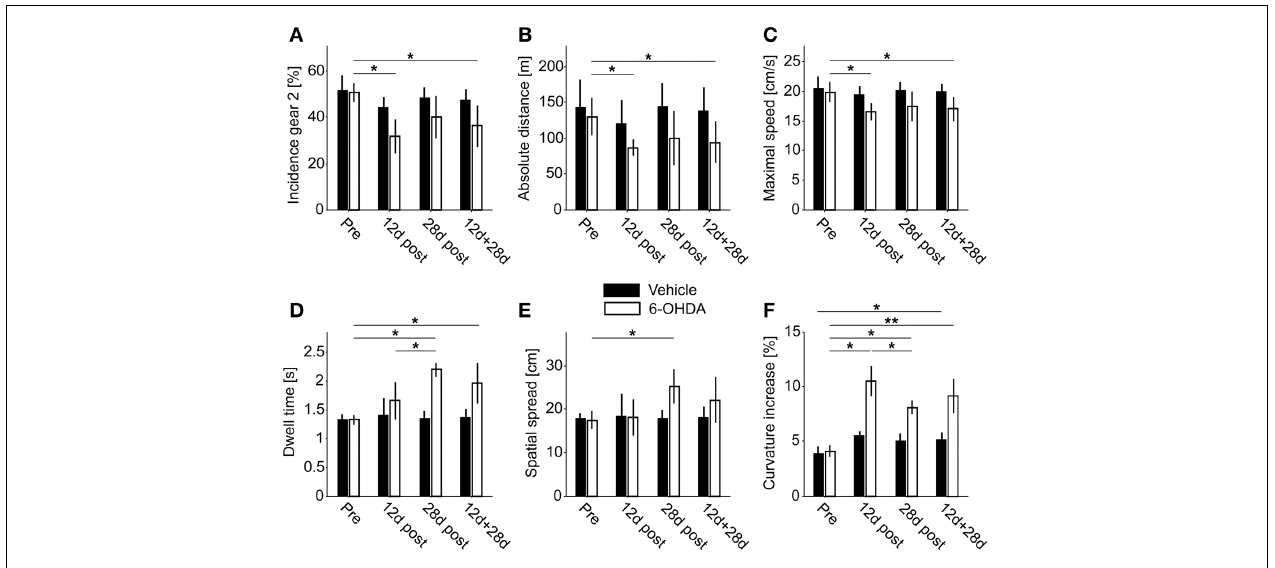
FIGURE 5 | Behavioral endpoints. (A) Incidence of second gear episodes. (B) Absolute covered distance. (C) Average maximal movement speed of second gear episodes. (D) Dwell time of second gear episodes. (E) Spatial